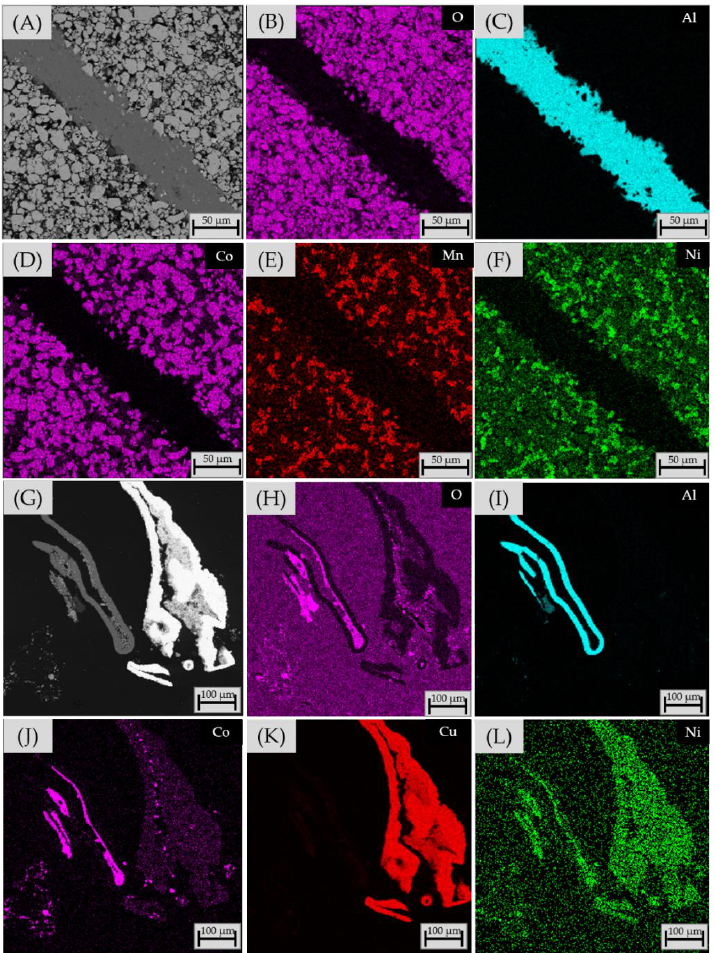
Figure 8. EDS-mapping of spent battery flotation underflow, ( A , G ) overview, ( B , H ) oxygen, ( C , I ) aluminum, ( D , J ) cobalt, ( E ) manganese, ( K ) copper, ( F , L )